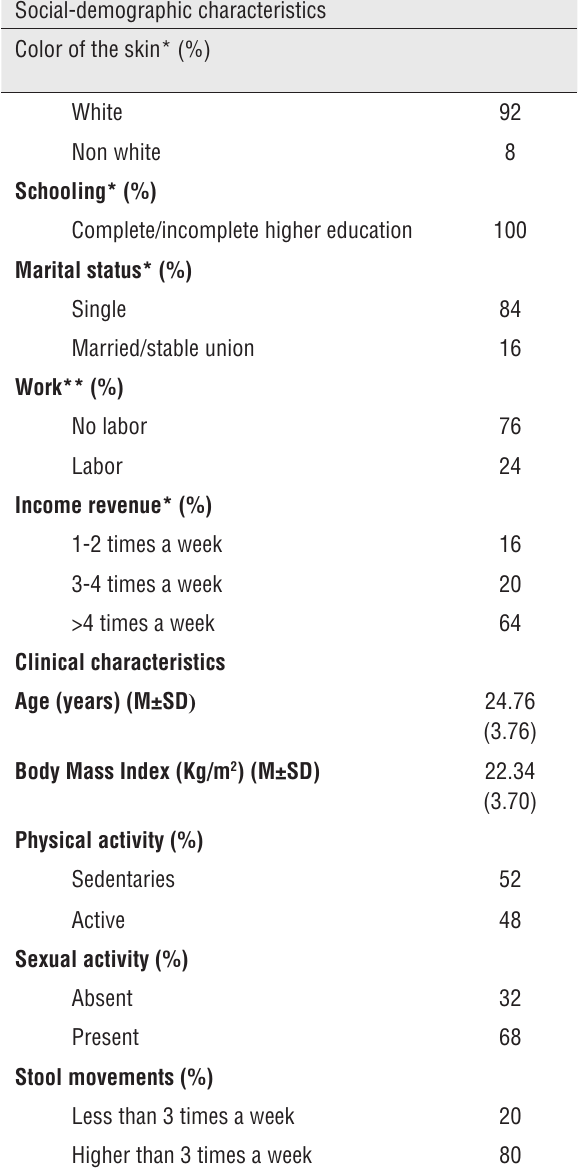
Table 1 - social-demographic and clinical characteristics of